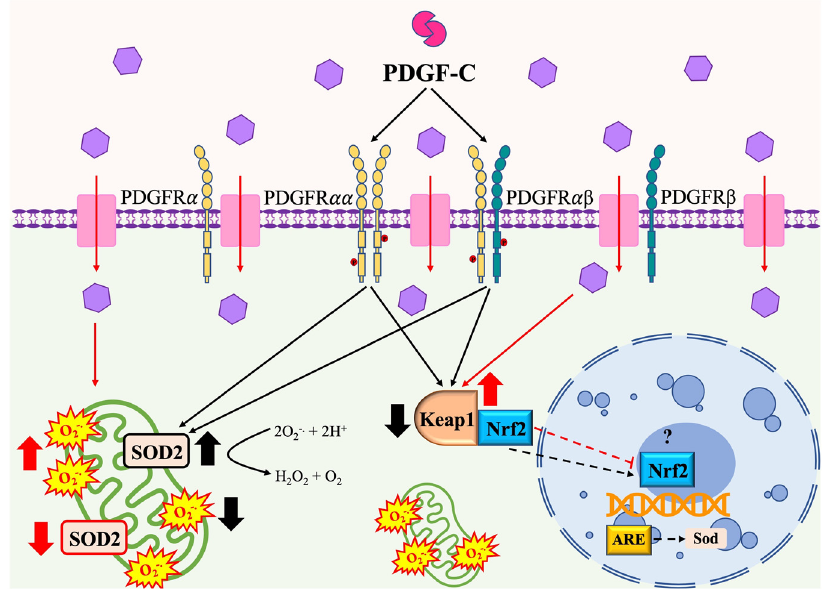
Figure 6. PDGF-C effects on high d-glucose-induced oxidative stress in HAECS. Read description in the text.